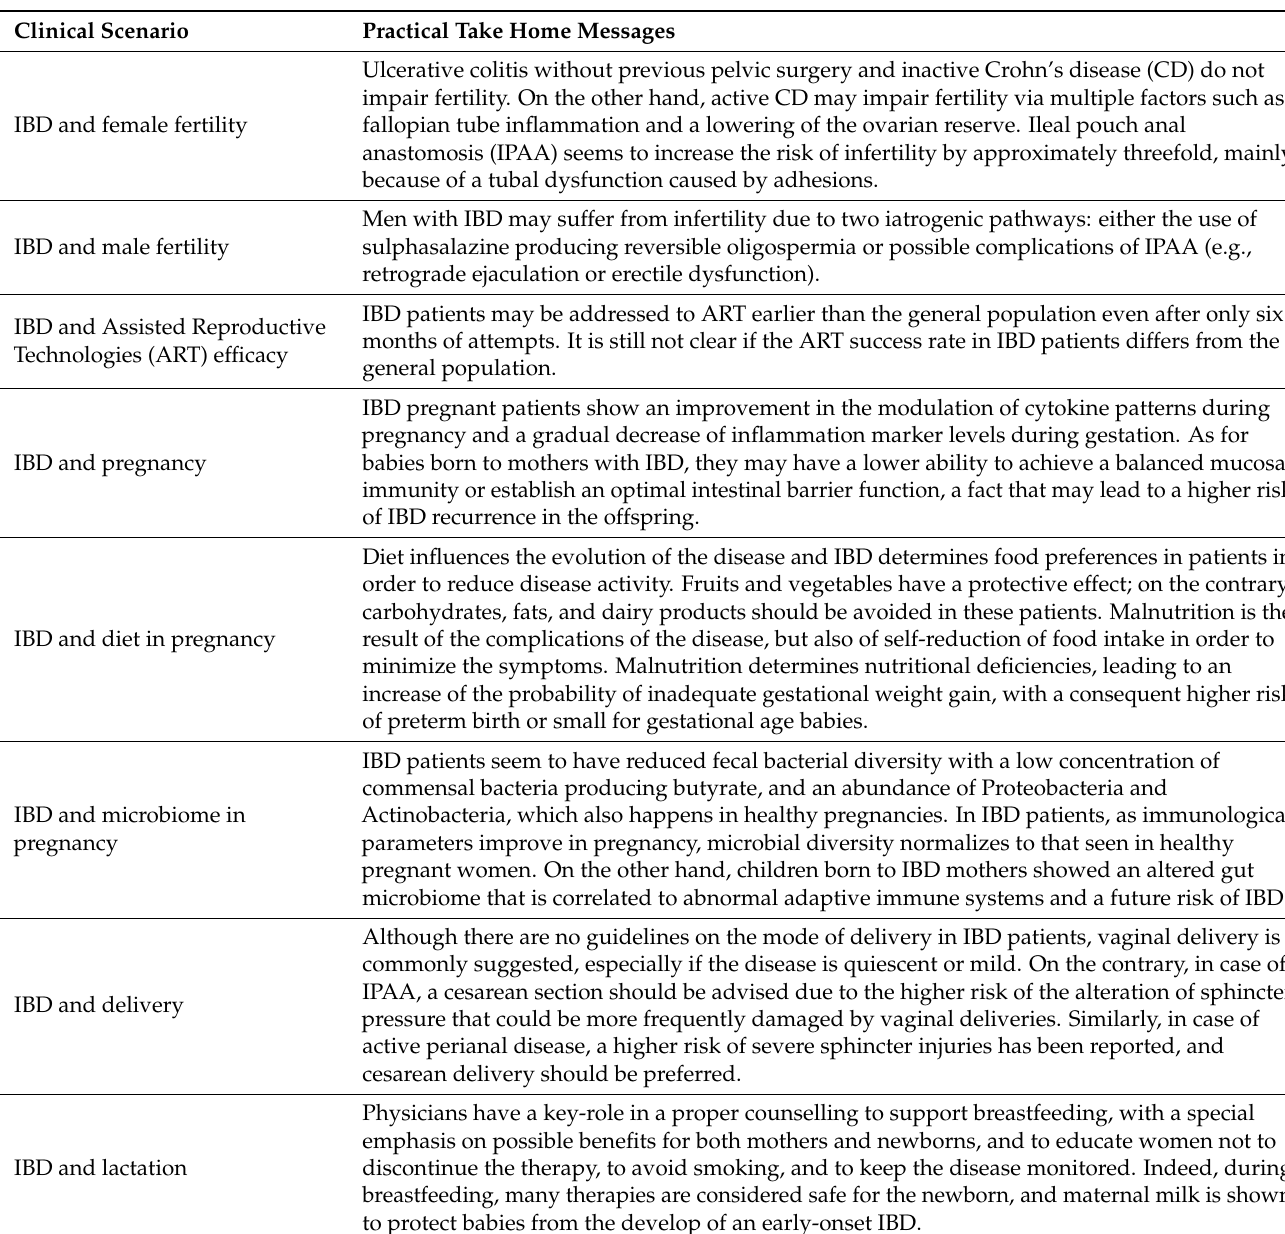
Practical take home messages for Inflammatory Bowel Diseases (IBD) patients in reproductive